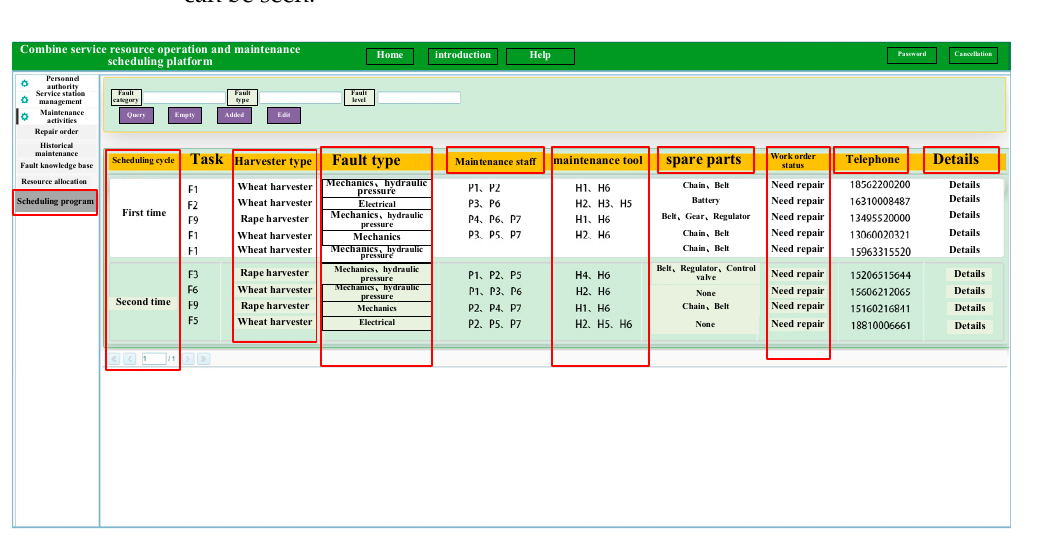
Figure 8. Final scheduling scheme.